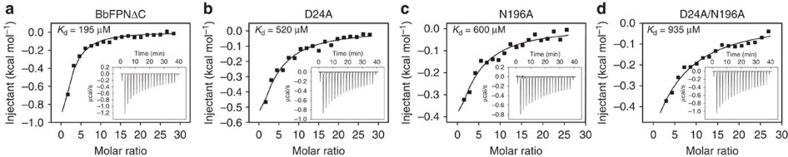
Isothermal titration calorimetry data of BbFPN.(a) The affinity of BbFPN toward Co2+ ion, measured using isothermal titration calorimetry. The data derived from (a) BbFPNΔC, (b) D24A, (c) N196A and (d) D24A/N196A double mutant are shown. The measurements were repeated twice, and similar results were obtained.